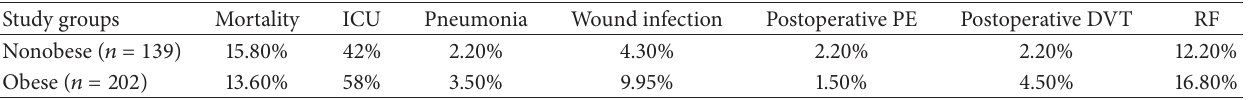
Table 2: Postoperative